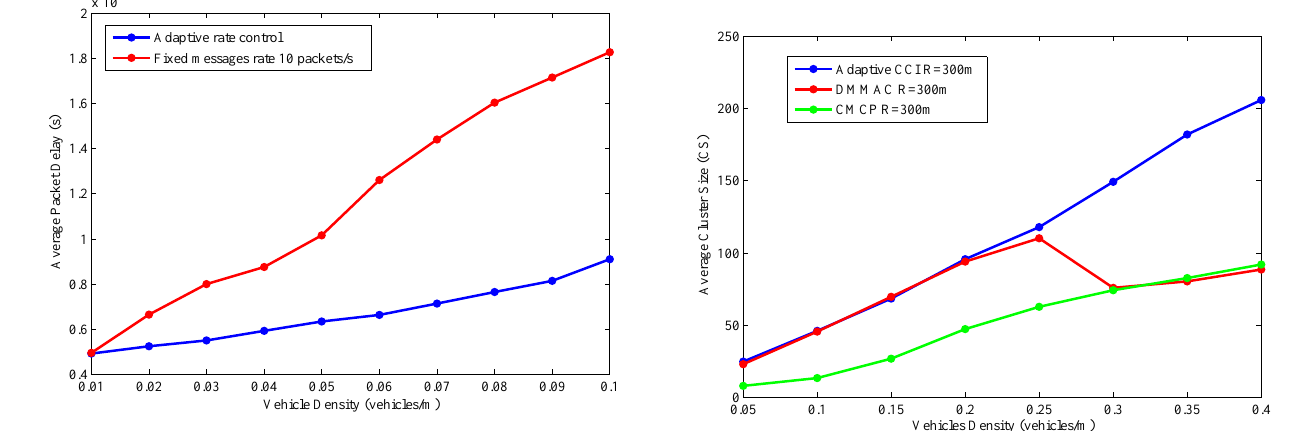
Figure 6. Cluster size versus vehicle’s